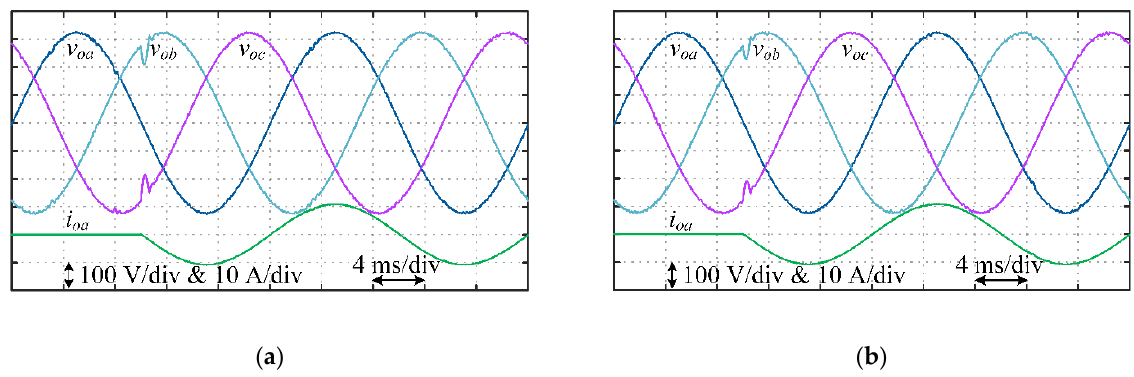
Figure 5. Simulation results showing transient performance under step-change of the load from zero to 5 kW of the VSI, ( a ) the proposed adaptive MPC, ( b ) conventional MPC.